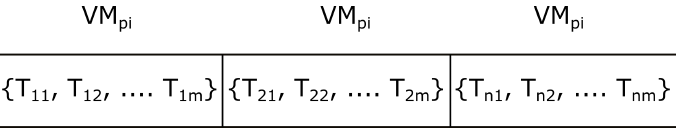
Figure 10. Representation of